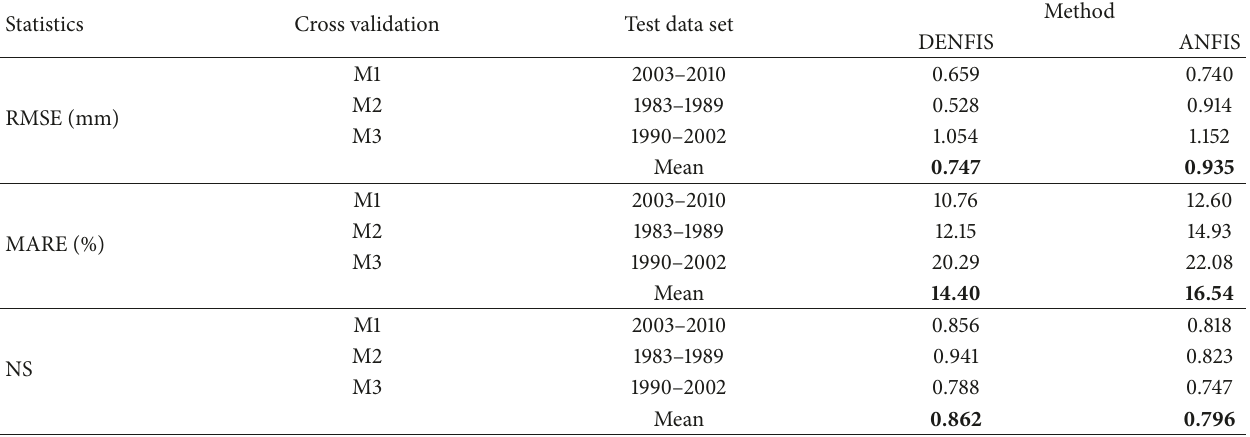
Table 4: Comparison of the DENFIS and ANFIS models in modeling pan evaporation—Antakya station.